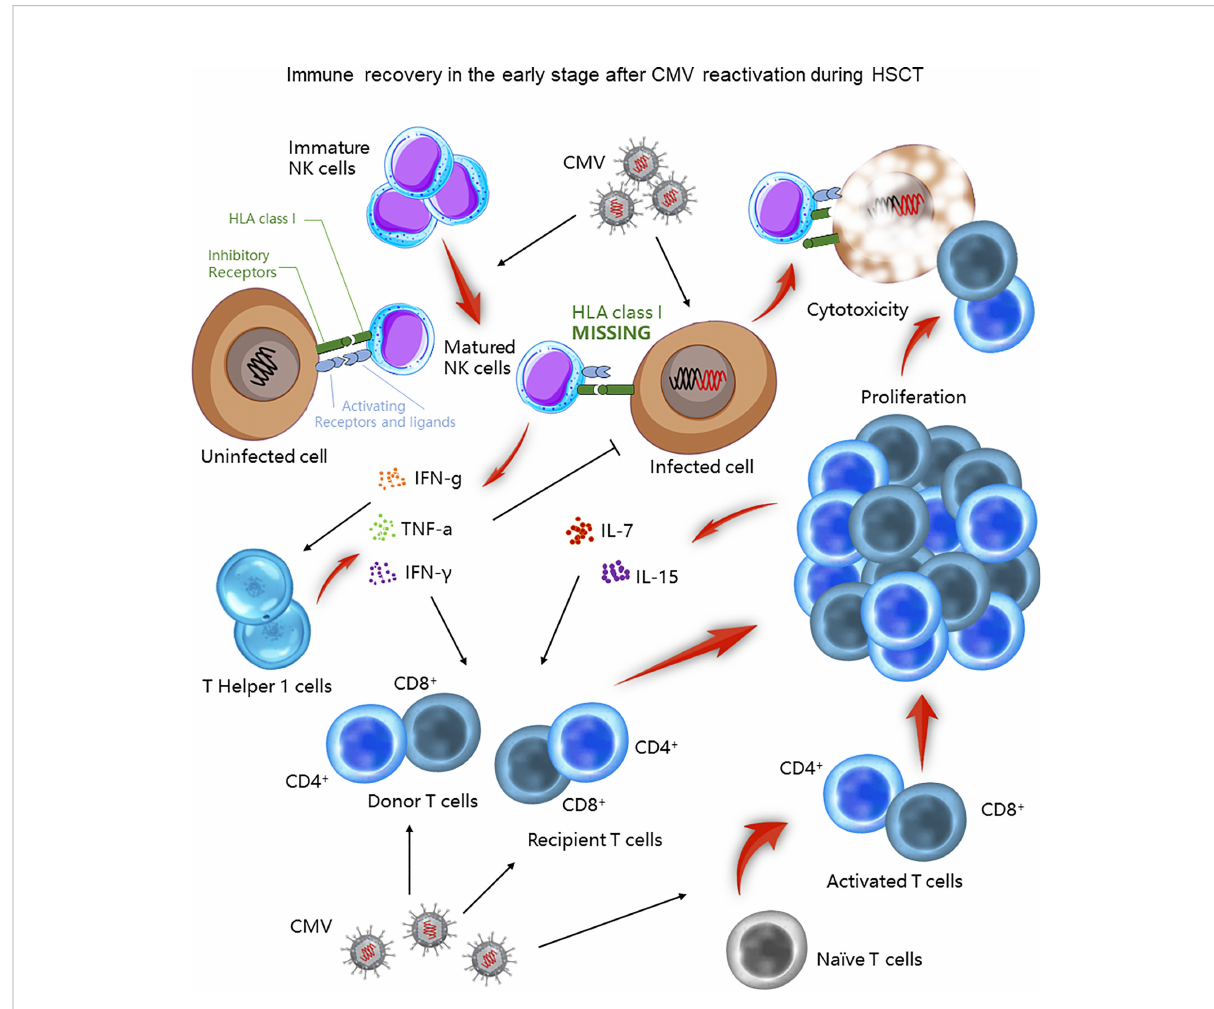
FIGURE 1 Immune recovery in the early stage after CMV infection during HSCT. During the fi rst 100 days after HSCT, NK and T cells play a crucial role in controlling CMV infection. Matured NK cells directly lyse CMV infected cells or indirectly facilitate Th1 responses to control CMV infection. T cells also exert their cytotoxic function through both existing and newly generated